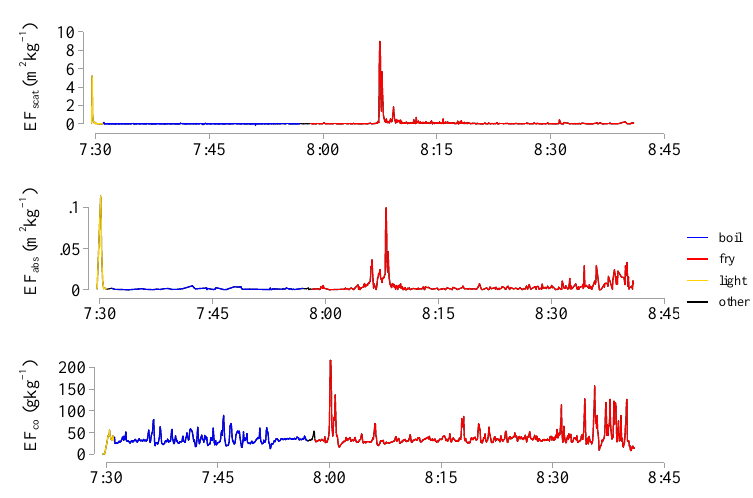
Figure 4. Real-time emission factors during a biogas cooking event (monsoon season), which includes lighting, boiling, and frying: ( top ) scattering emission factor; ( middle ) absorption emission factor; and ( bottom ) CO emission